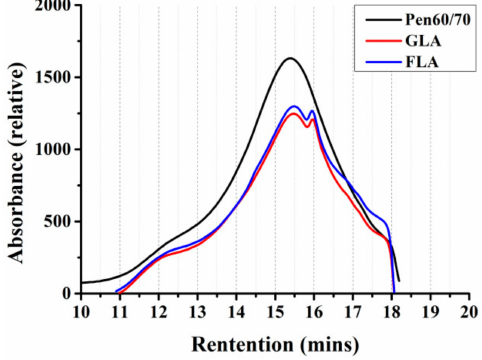
Figure 8. Gel permeation chromatography (GPC) chromatograms of test binders.